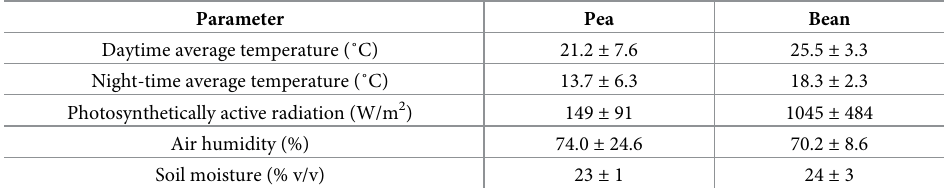
Table 2. Environmental data of growing period.